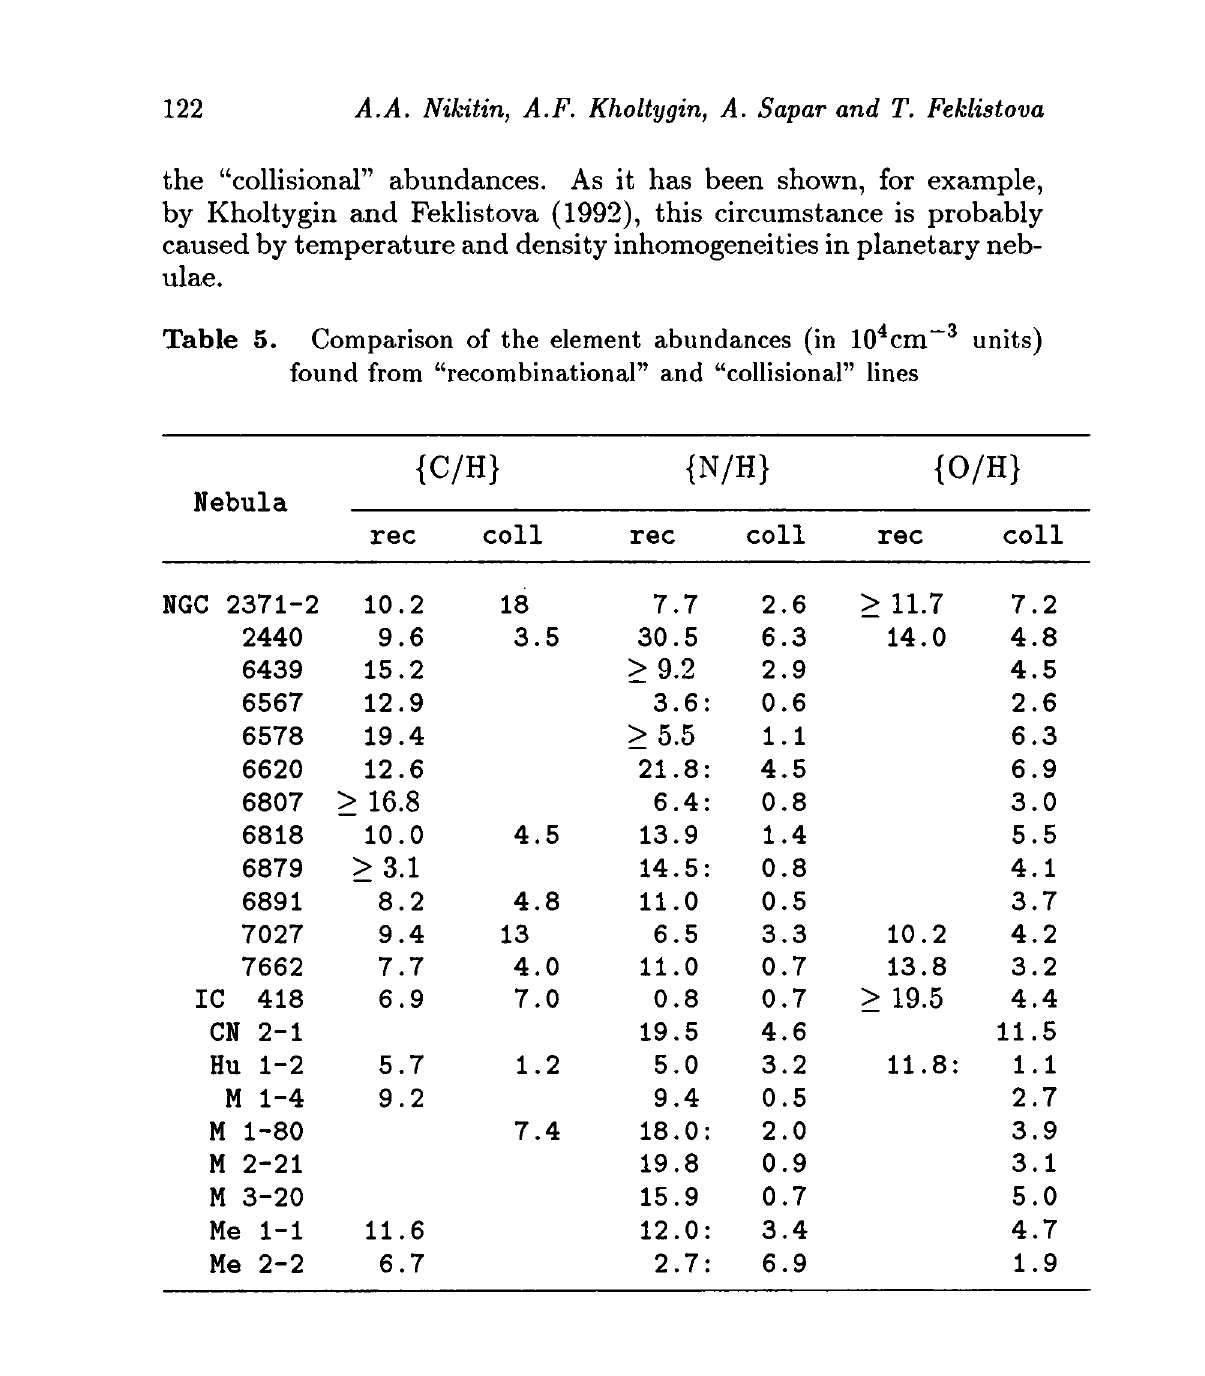
Comparison of the element abundances (in 10 4 cm -3 units) found from "recombinational" and "collisional"